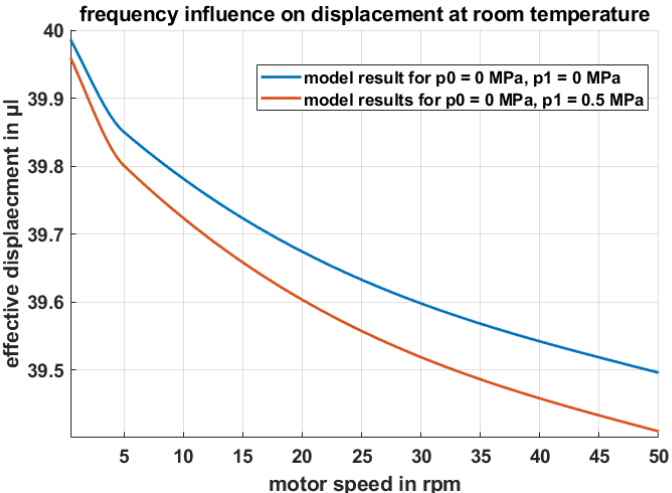
Figure 10. Calculated displacement curve based on V0 = 40 µL for idle mode and nominal load pressure over desired motor speed. .